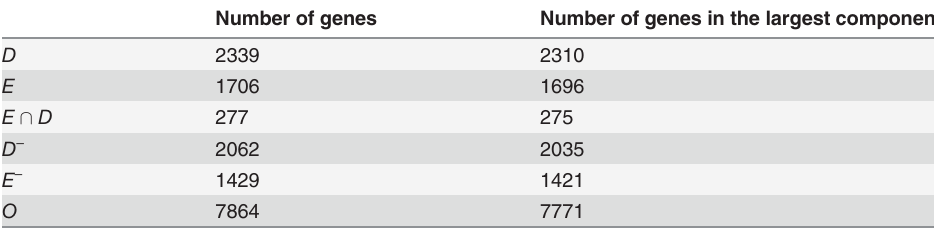
Table 3. Statistics of the genes in the protein interaction network constructed based on the STRING